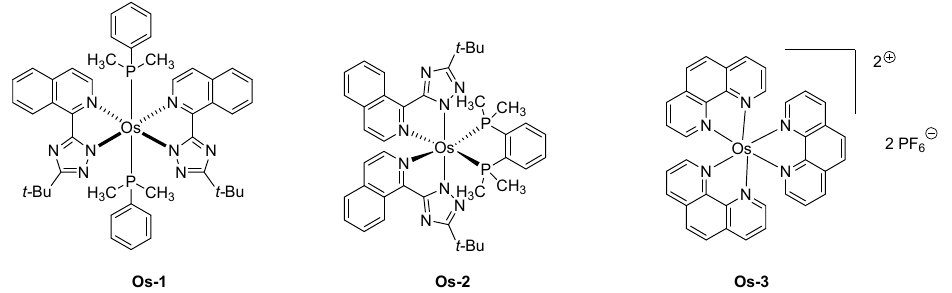
Figure 12. Os-based near-infrared (NIR) emitters for light-emitting diodes.